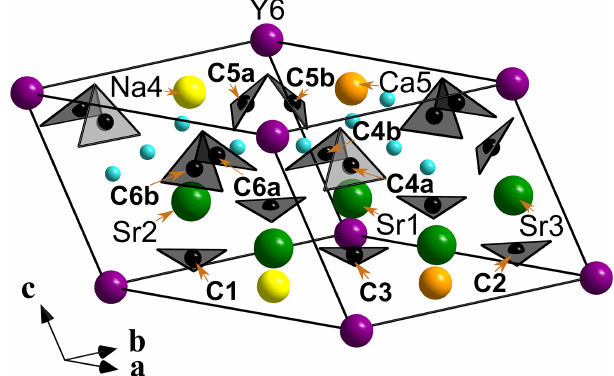
Figure 3. General view of the crystal structure of donnayite-(Y). Sky-blue spheres are H 2 O molecules. The unit cell is outlined.